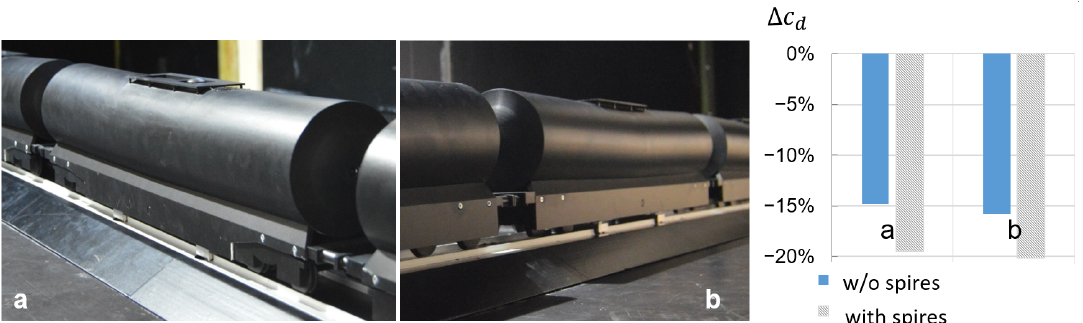
Figure 7. Side skirt variants. ( Left ): a with cut-outs for the bogies b without cut-outs; ( Right ): ob- tained drag reductions.